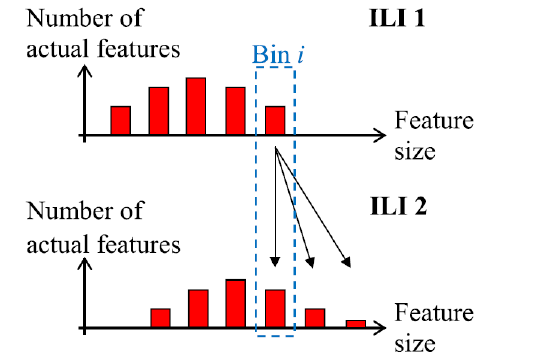
Figure 61. The shift in the distribution of the defects to the right is observed by comparing the distribution generated by two successive in-line inspections (ILI1 and ILI2). Reprinted from Reliability Engineering & System Safety, Volume 180, Dann, M.R.; Maes, M.A. Stochastic Corrosion